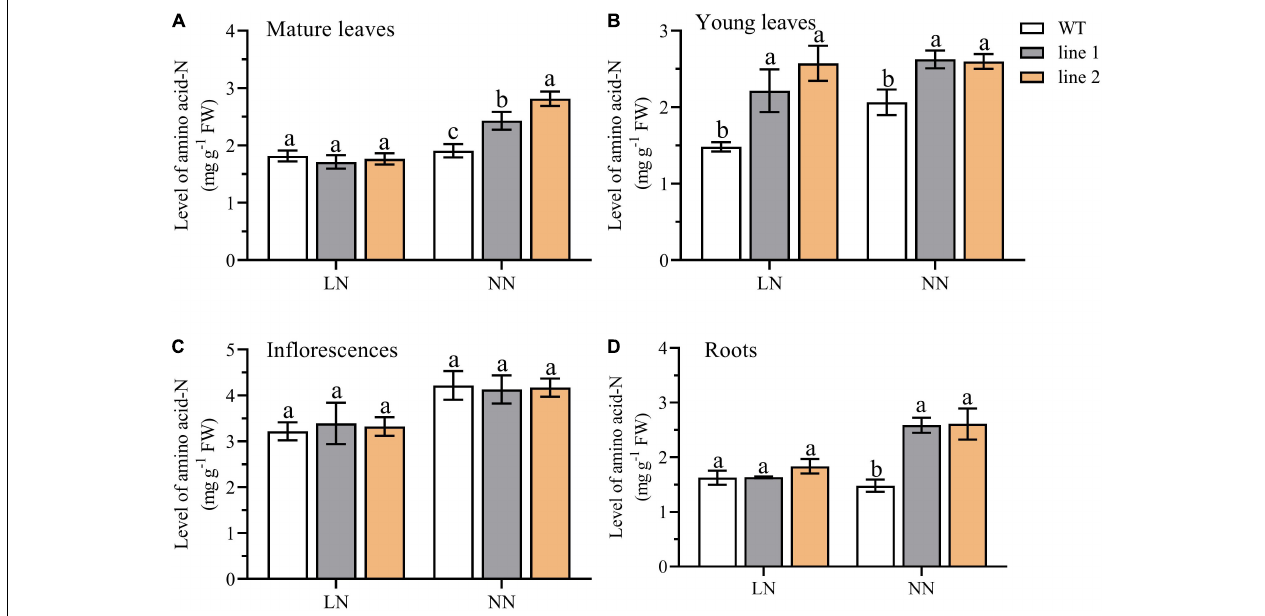
FIGURE 3 | A comparison of the amino acid-N level in mature leaves (A) and young leaves (B) of rosette, inflorescences (C) , and roots (D) between the two transgenic Arabidopsis lines and wild type. Plants were hydroponically cultured for 3 weeks under NN, and then under LN and NN for 2 weeks ( n ≥ 5). Three biological replicates were performed. Data are means ± SD . Significant differences are indicated by letters (ANOVA; P ≤ 0.05). WT, wild type (Col-0), line 1 and line 2, two transgenic lines. LN, low nitrogen, 0.25 mM N (0.125 mM NH 4 NO 3 ); NN, normal nitrogen, 5 mM N (2.5 mM NH 4 NO 3 ).